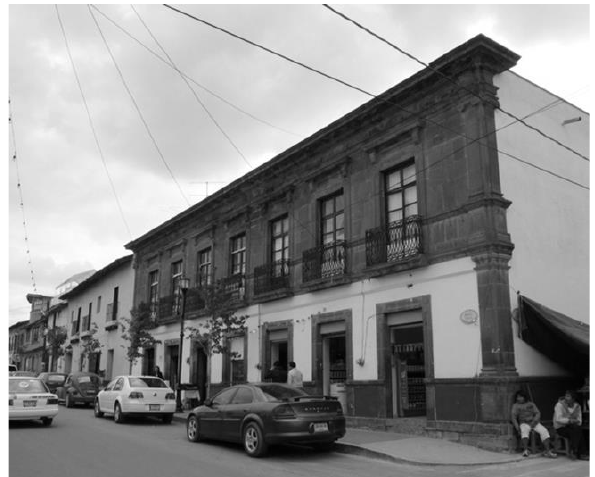
Figure 5. Two-story housing typologies. (Source: